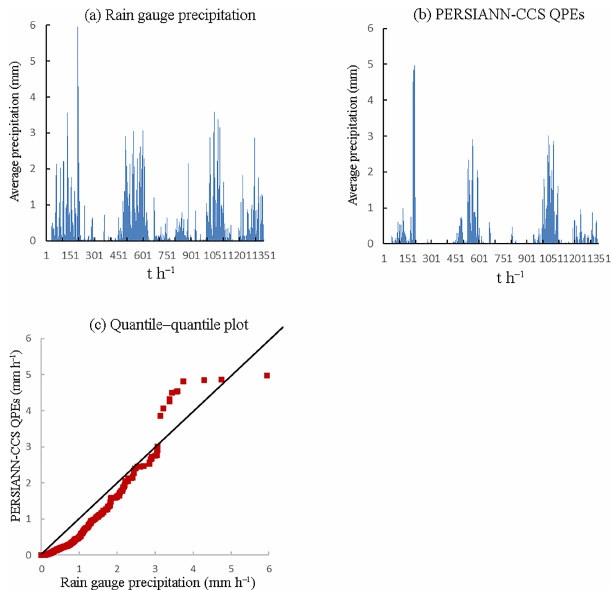
Figure 4. Precipitation pattern comparison of two precipitation products (2008): (a) is the average precipitation of rain gauges, (b) is the average precipitation of PERSIANN-CCS QPEs, and (c) is the quantile–quantile plot, in which the 45 ◦ line is used to compare the two precipitation products.